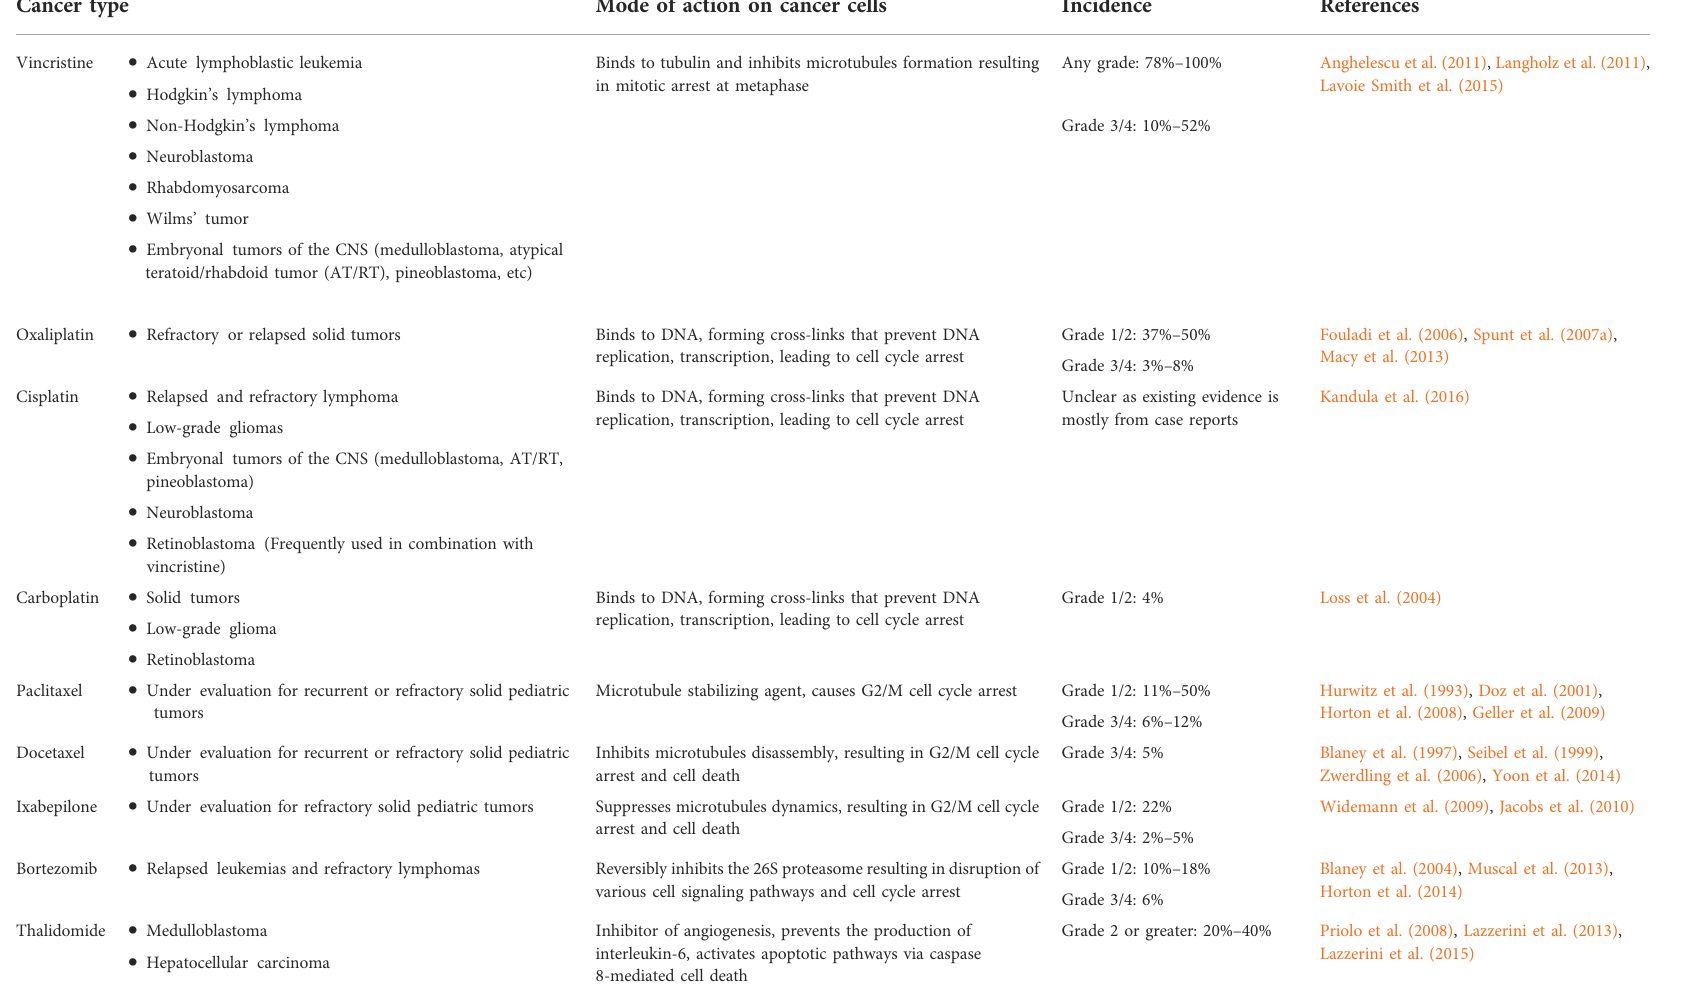
TABLE 2 Summary of the mode of action and incidence of pediatric CIPN associated with various chemotherapeutic agents. WHO scale of CIPN grades: Grade 1: paresthesia and/or decreased tendon re fl exes; Grade 2: severe paresthesia and/or mild weakness, Grade 3: intolerable paresthesia and/or marked motor loss; Grade 4: paralysis (Miller et al.,